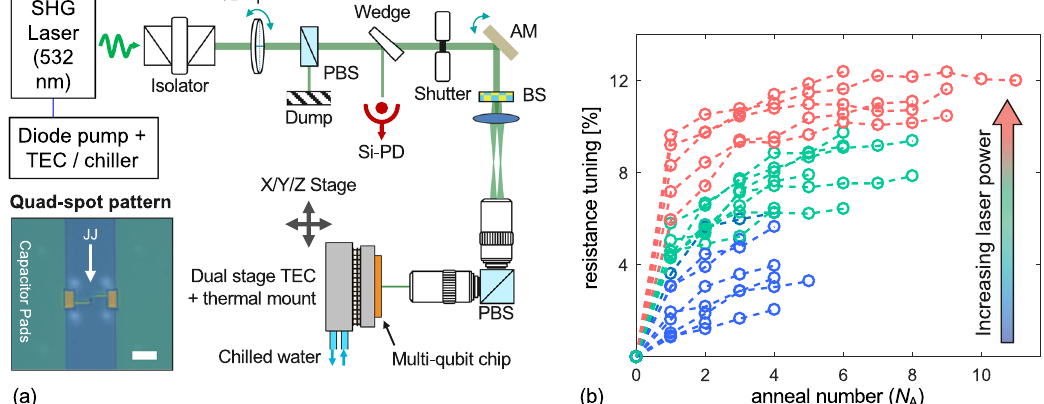
Fig. 2 “ Laser annealing of stochastically impaired qubits ” (LASIQ). a Schematic of the apparatus. A 532 nm (frequency doubled) diode- pumped solid-state laser is used as the laser annealing source. Active power calibration is accomplished via a half-wave plate and PBS combination, with feedback from a Si-PD. A piezoelectric mirror mount actively aligns the beam to the junction center via image pattern recognition. The beam is shaped into a four spot pattern in an intermediate image plane by a diffractive beam splitter, to avoid direct illumination of the junction. The illumination pattern is condensed 4× using a dual-objective relay imaging set-up 51,53 . Inset with 10 μ m scale bar shows typical qubit junction and surrounding substrate heated by four Gaussian beam spots of diameter ~4 μ m. b Adaptive anneal progression toward R n targets in 20 tunnel junctions. Greater fractional tuning requires greater anneal powers or durations. Incremental exposure (anneal number) permits tracking the resistance change so as to monotonically approach a target resistance and not overshoot it. In this demonstration, colors blue, green, and red correspond to laser powers 1.74, 1.85, and 1.96 W, respectively. R n shift was calibrated separately for each power. Single anneals lasted ~0.3 – 8 s. Total durations were ~8 – 22 s. SHG second harmonic generation, PBS polarizing beam splitter, Si-PD silicon photodiode, AM alignment mirror, BS beam splitter, TEC thermoelectric